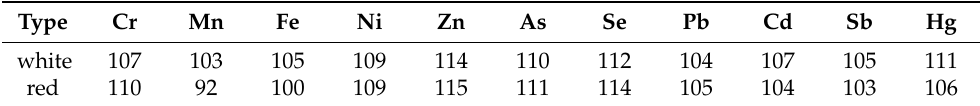
Table 4. Recovery percentage for selected metals in spike